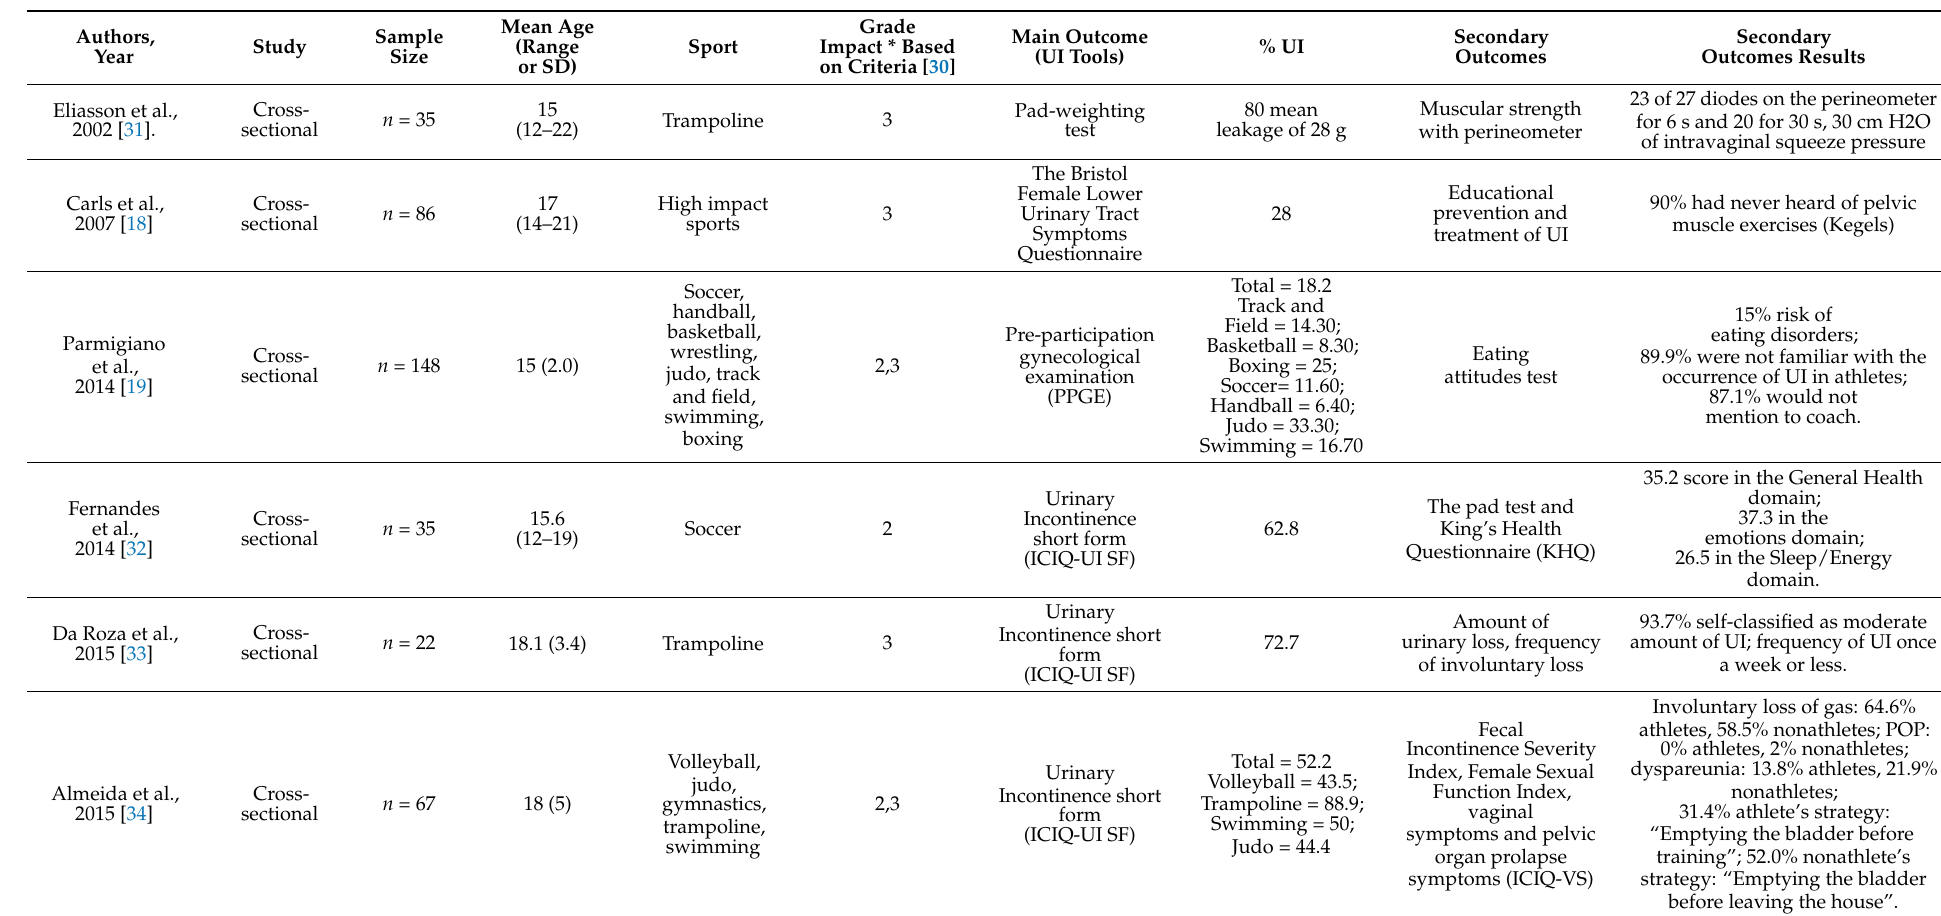
Table 1. Summary of the studies included in this